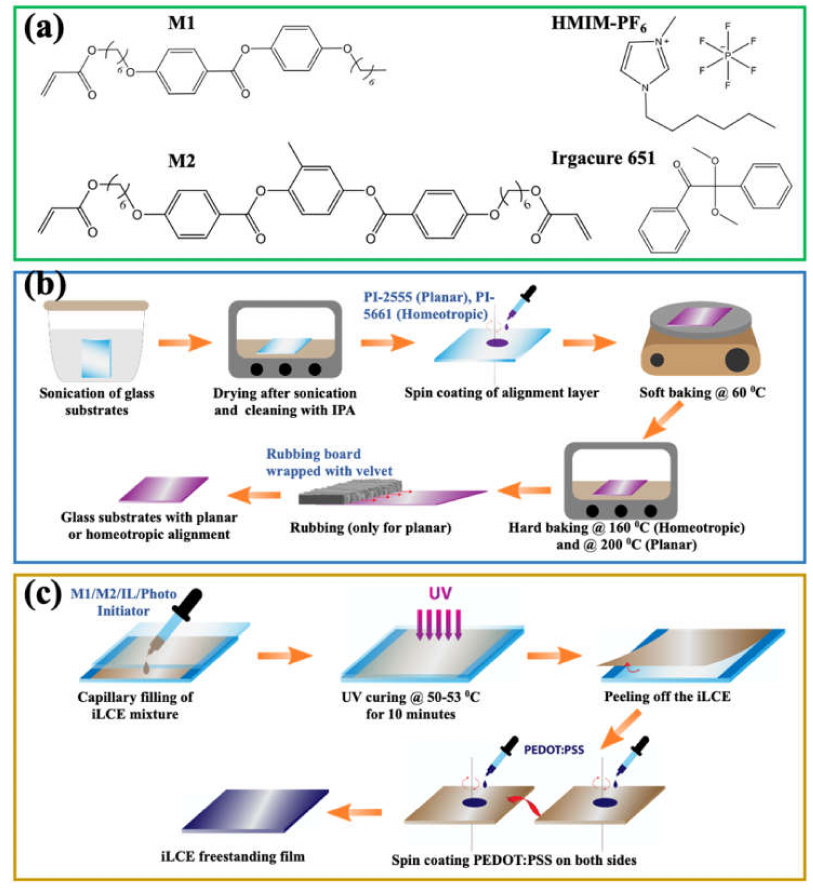
Figure 5. Molecular structures of the components of the iLCE materials and the illustration of sample preparation. ( a ) Molecular structures of the components of the studied iLCE: M1 and M2 are mesogenic units, HMIM-PF 6 is the ionic liquid, and Irgacure 651 is the photoinitiator. ( b ) Schematic view of preparation of the planarly and homeotropically aligned glass substrates. ( c ) Schematic view of fabrication of differently aligned (planar, homeotropic, hybrid, isotropic) iLCE films with PEDOT:PSS